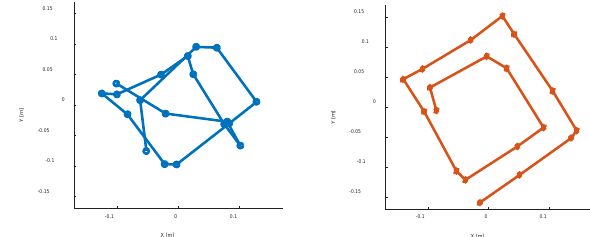
Figure 8: The measured magnetic signal when moving the IMU in a spiral pattern under a heterogeneous magnetic field.